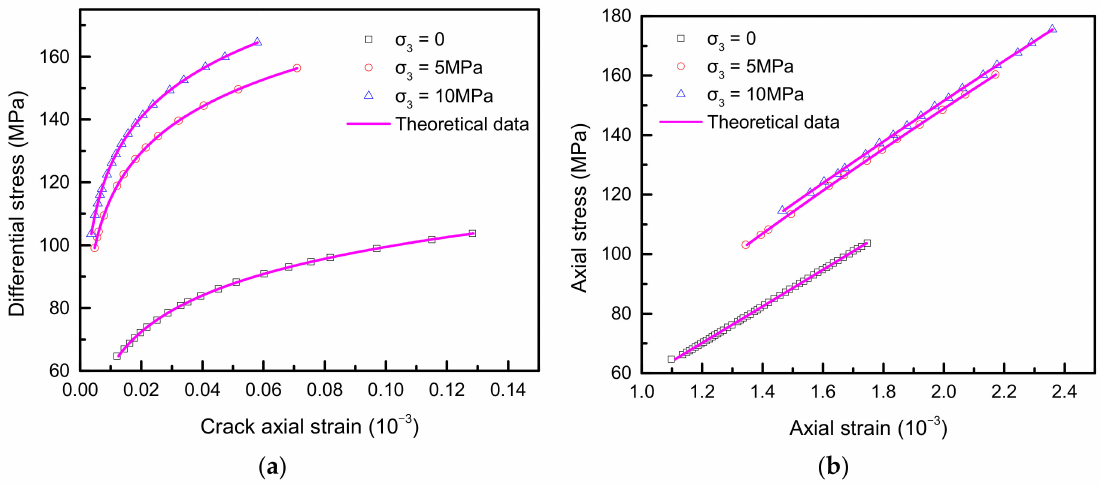
Figure 5. Stress–strain test values and theoretical curves at the stage of stable crack propagation in rock: ( a ) differential stress–axial crack strain; ( b ) axial stress–axial strain. Table 1. Theoretical parameters of granite crack stable propagation model.